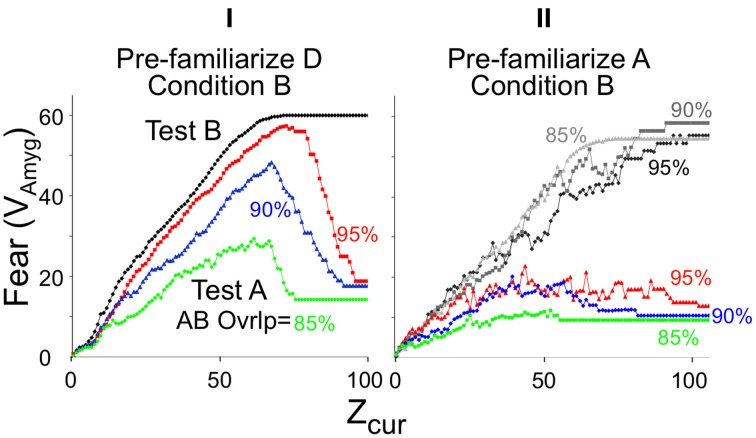
Generalization of context fear. BACON was conditioned by a shock at the end of a session in novel context B and then tested either in the conditioning context (black and gray curves) or in a generalization context A (colored curves). Context A's similarity to B was either 85% (green), 90% (blue), or 95% (red). The automaton was pre-exposed to either the generalization context (A) (II) or to a very different context (D) as a control for per-exposure per se
(I). Because degree of conditioning is somewhat affected by pre-exposure to a context similar to the conditioning context, separate conditioning-context tests had to be run for each pre-exposed generalization context (shades of gray in II). Each curve is the average of 30 simulations. The pre-familiarization session was 95 samples, the conditioning session 80, and the test session 99.